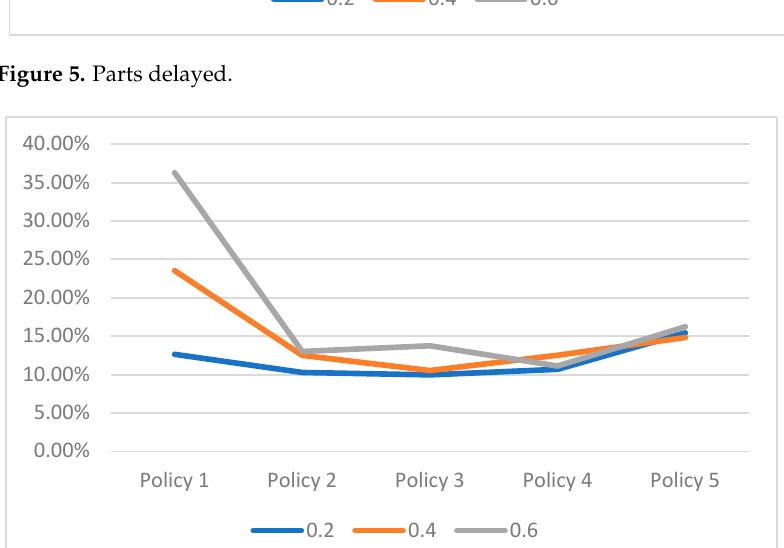
Figure 5. Parts delayed.